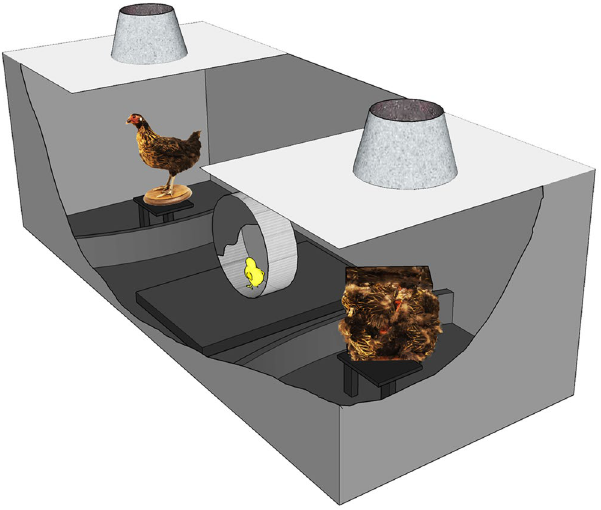
Figure 1. Schematic representation of the experimental apparatus. Visually naïve domestic chicks were placed in the running wheel and were free to run for 30 min towards one or the other stimuli, which were constantly rotating at the ends of the runway. The ‘stuffed fowl’ resembled the static configurations of a conspecific and the control stimulus was a ‘texture fowl’ (i.e., small pieces of an identical stuffed jungle fowl affixed in a scrambled fashion to the sides of a box). The behavior was monitored from above through a video camera and the sum of rotations in one or the other direction was recorded by an automated system.